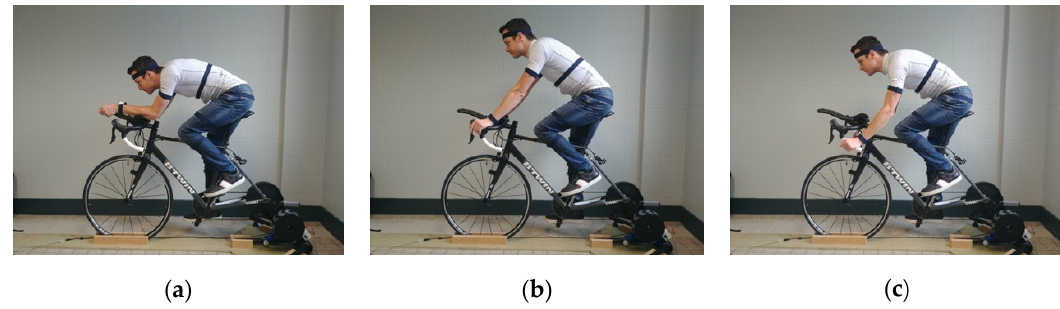
Figure 3. A participant photographed in three poses as instructed in the Static protocol ( a ) TT , ( b ) Hoods , and ( c ) Drops .